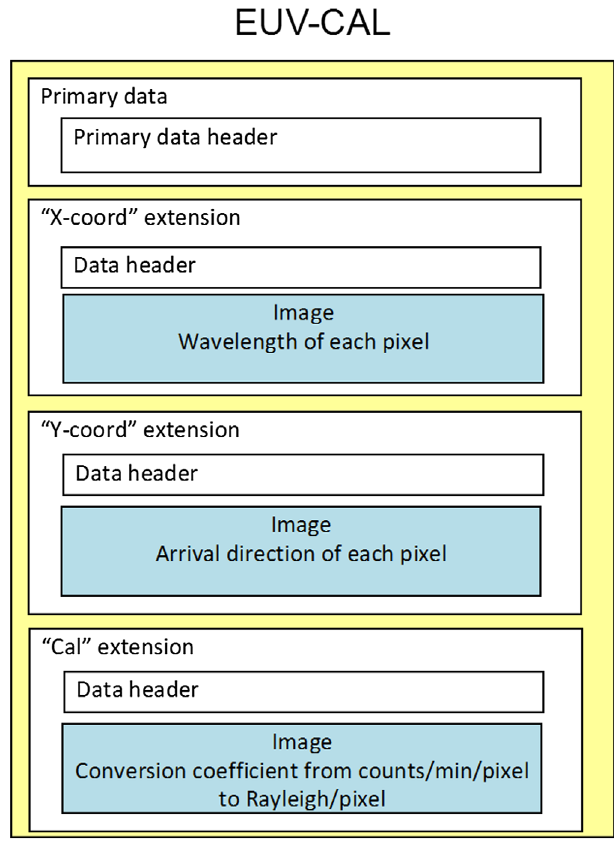
Fig. 10. FITS fi le structures of EUV-CAL.